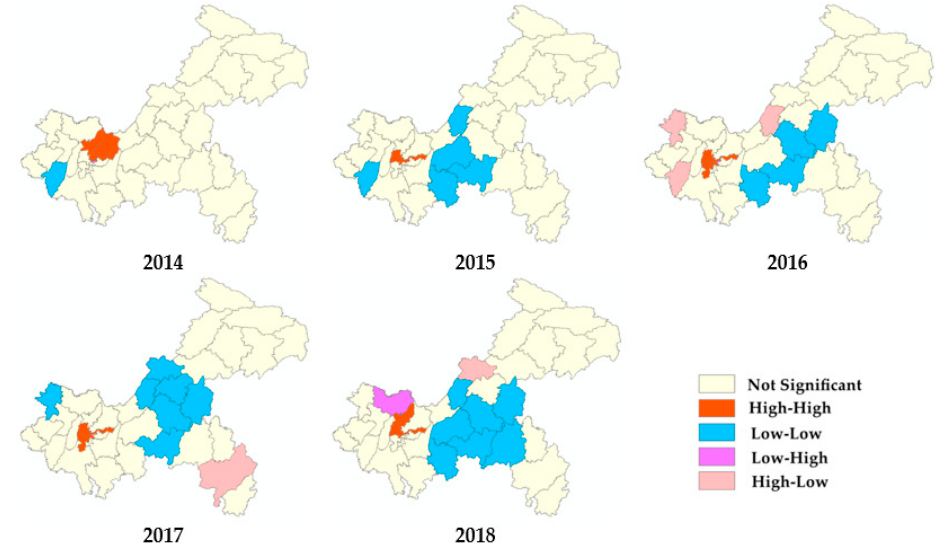
Figure 4. Local spatial autocorrelation cluster maps of varicella in Chongqing in 2014–2018.